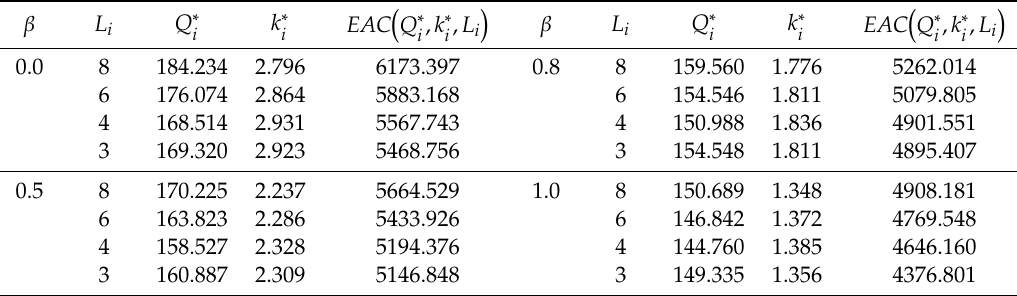
Table 2. Our solution for the example in Wu and Ouyang